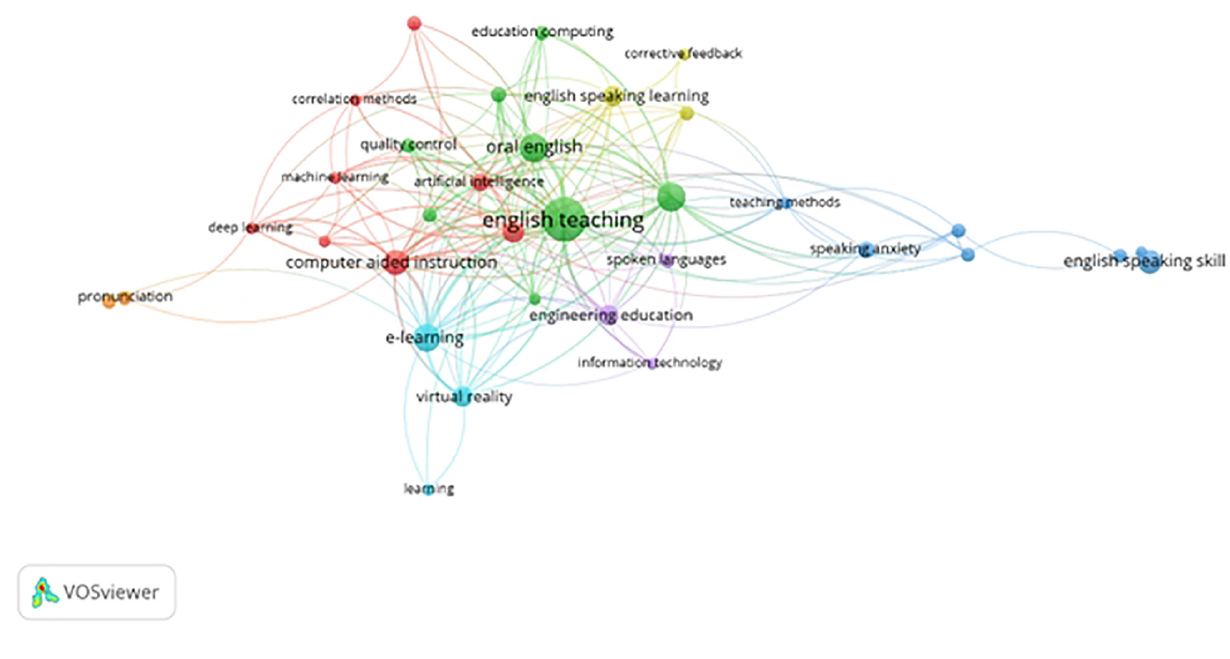
Frontiers in Education |